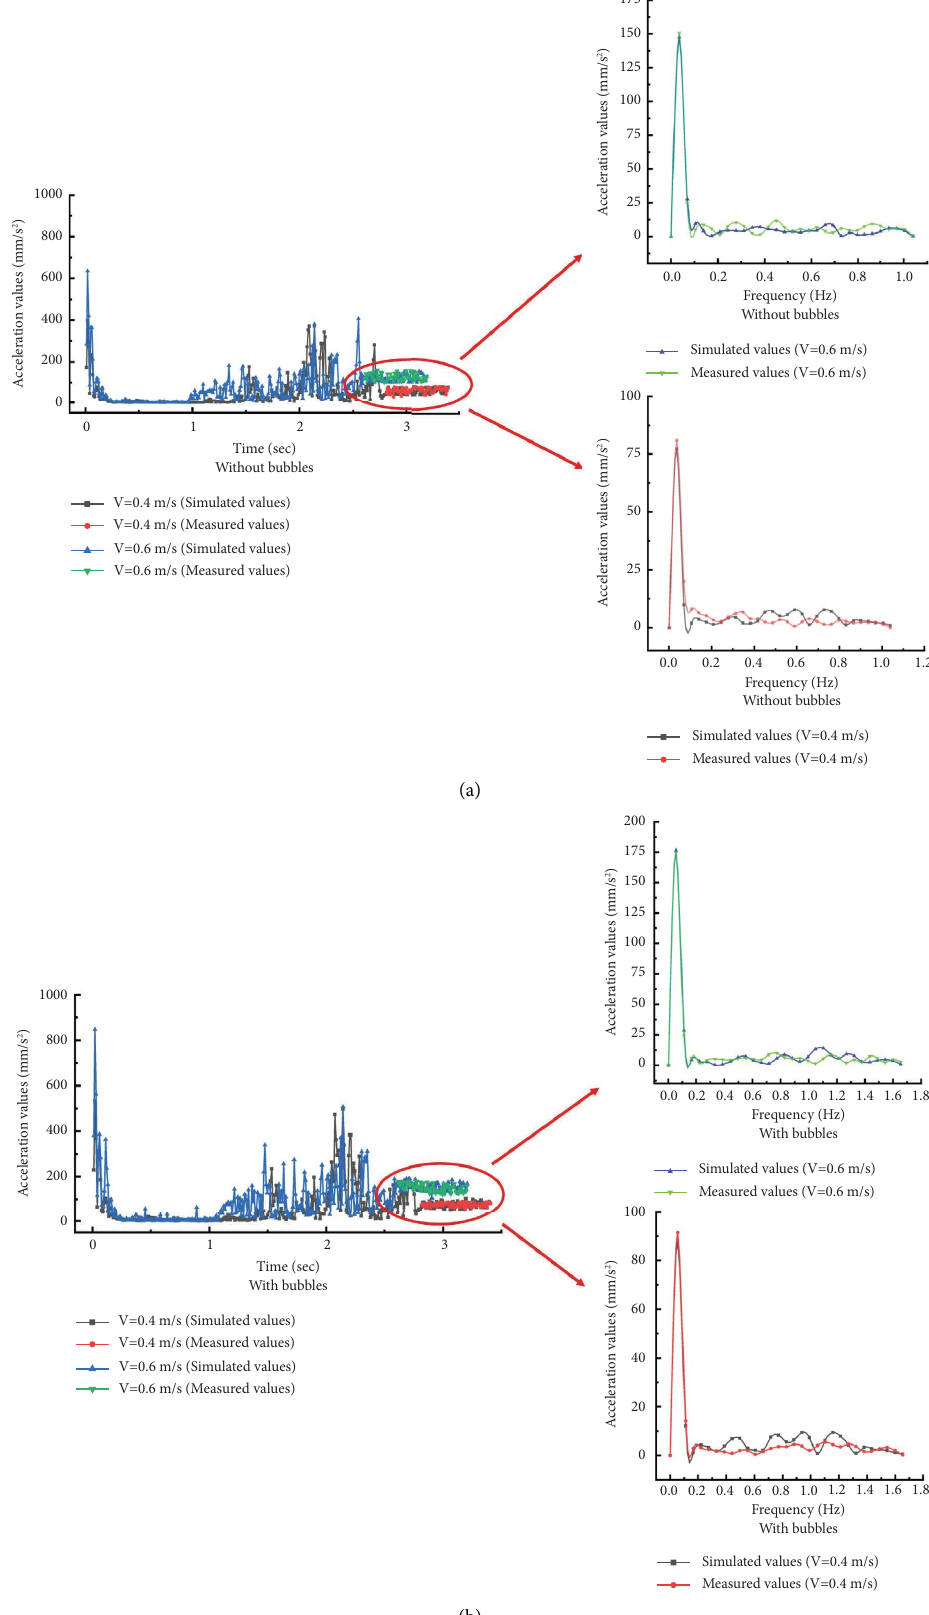
Figure 12: Diagram of the comparison results between measured and simulated acceleration values. (a) Without bubbles. (b) With